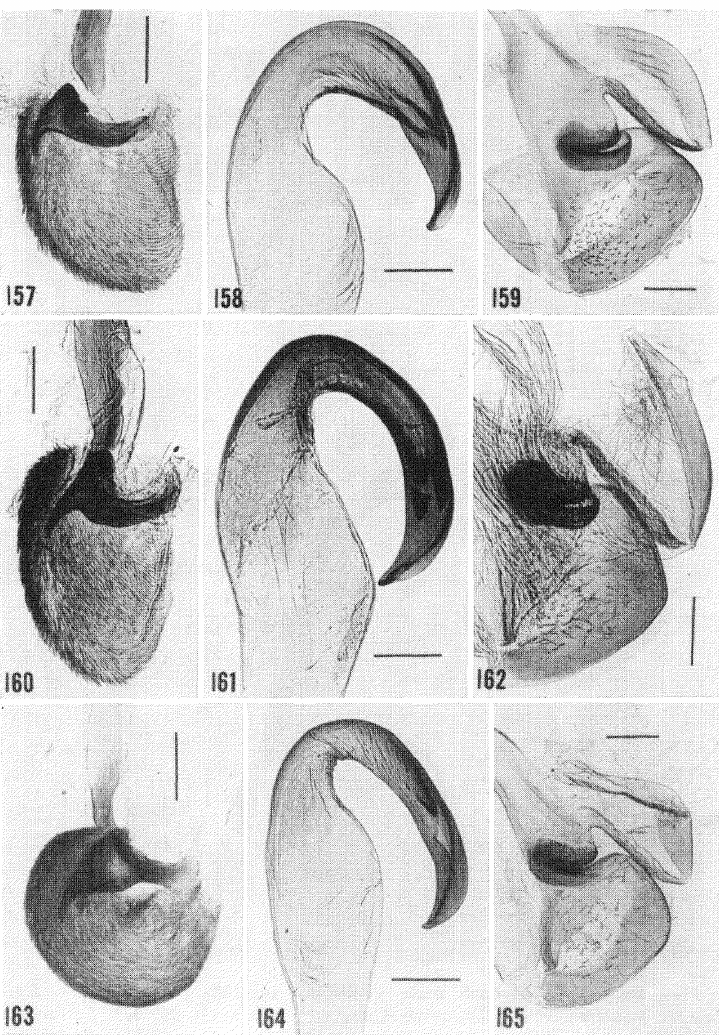
Figs. 157-165. Cockroach male genitalia. 157-162. Eilampra gund’lachi. 157-159. (97 USNM). Cayamas, Cuba (det. Hebard). 160-162. (23 MCZ). Mountains north of Imias, Oriente Province, Cuba (det. Gurney). 163- 165. (69 USNM). Epilampra haitensis. Port-au-Prince, Haiti (det. Albuquer- que).